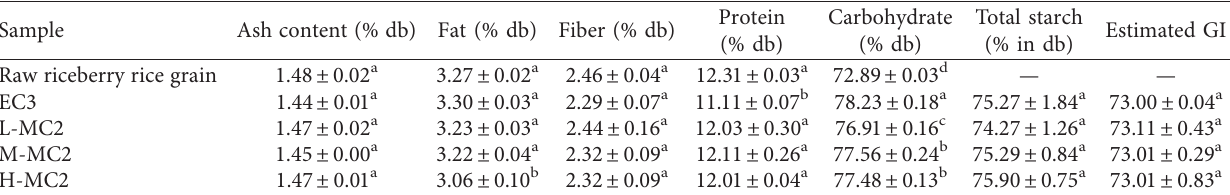
Table 4: Chemical composition of the Riceberry rice grain ( Oryza sativa L.) and the cooked rice from conventional cooking and microwave